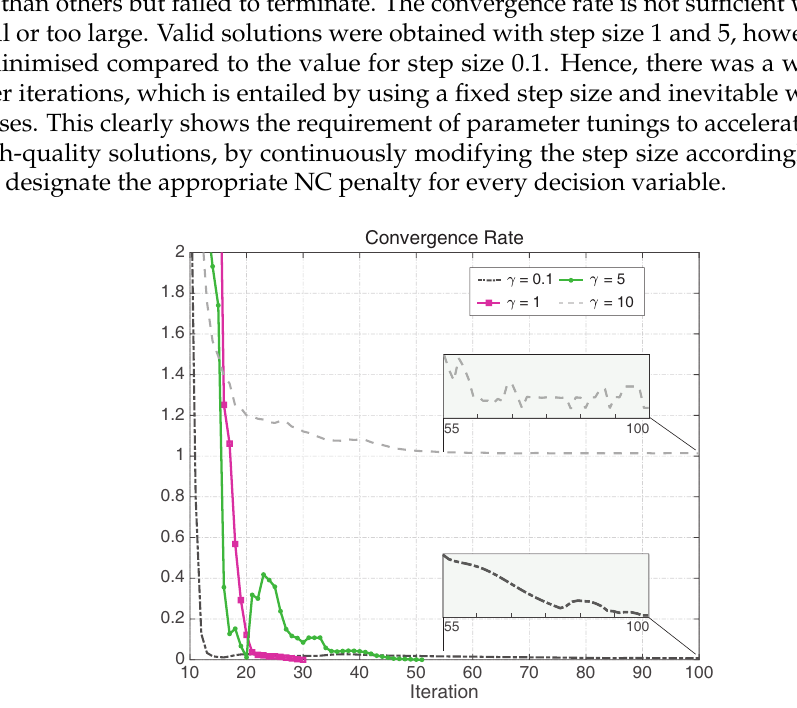
Figure 4. Progressive hedging (PH) method convergence rate for varying step size γ